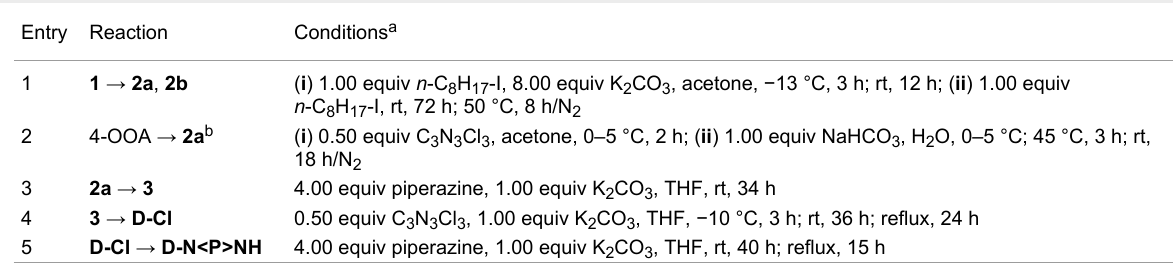
Table 1: Reagents and conditions in the synthesis of compounds 2a , 2b , 3 , D-Cl and D-N<P>NH . Entry